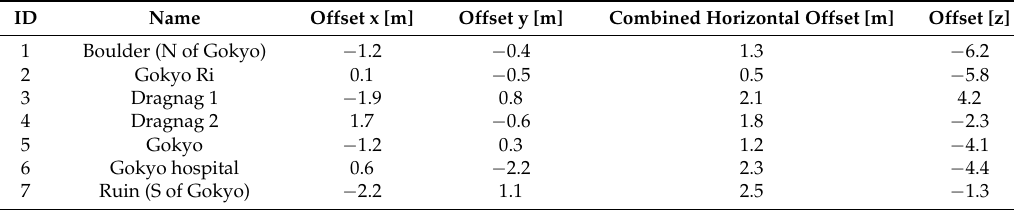
Table 4. X and y offset of the ground control point (GCP) in relation to the 2016